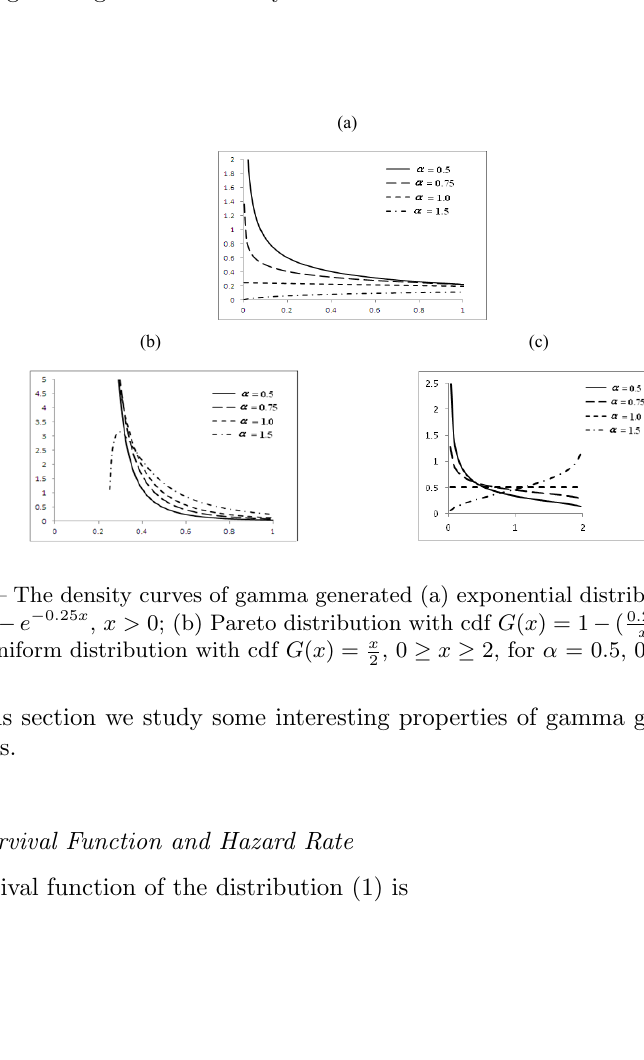
) 2 , x (cid:21) 0 : 25, x , 0 (cid:21) x (cid:21) 2, for (cid:11) = 0.5, 0.75, 1, 2